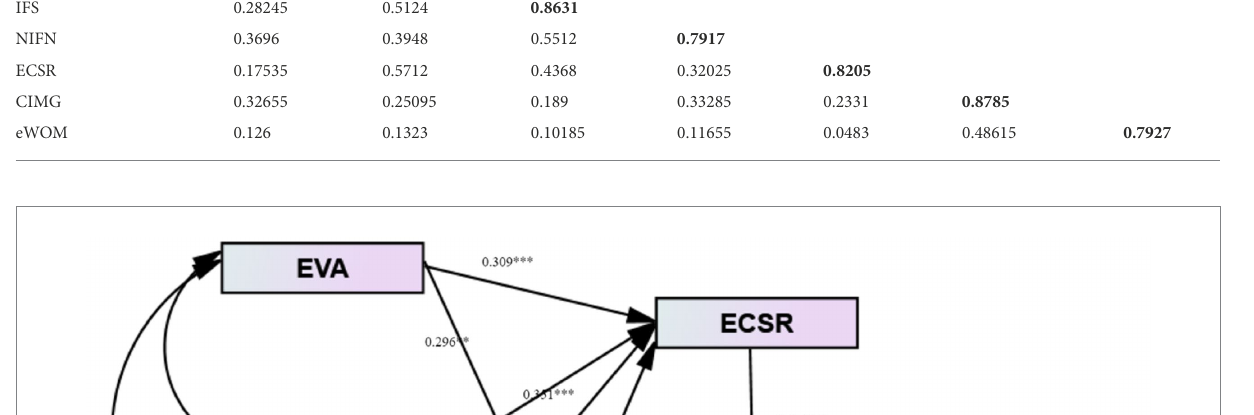
TABLE 5 Discriminate validity analysis.